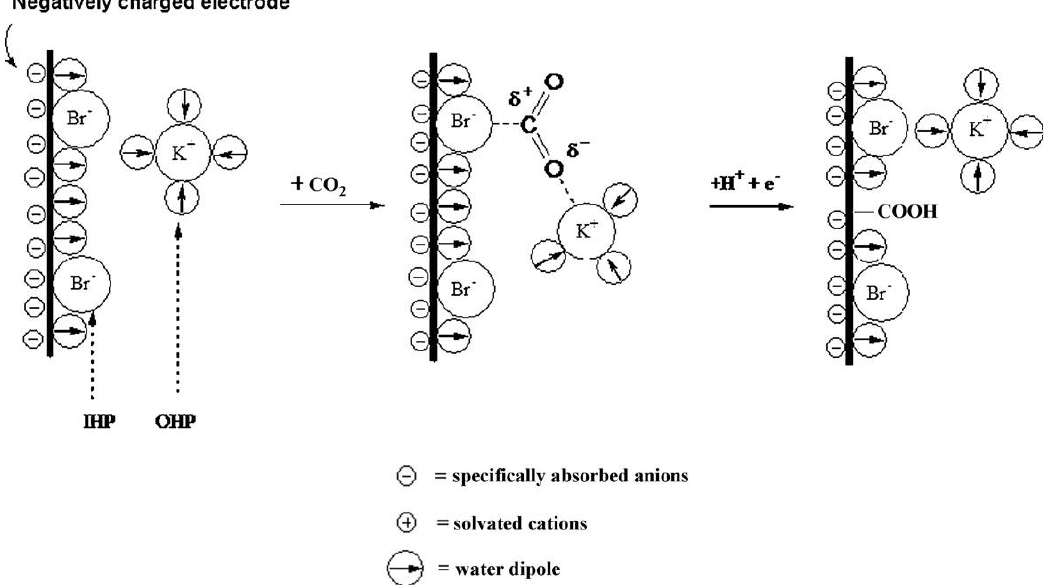
Figure 14. Schematic of specifically adsorbed anions (Br − ), approach of CO 2 , and subsequent elec- trochemical reduction. Reprinted from Ref. [141], copyright (2010), with permission from